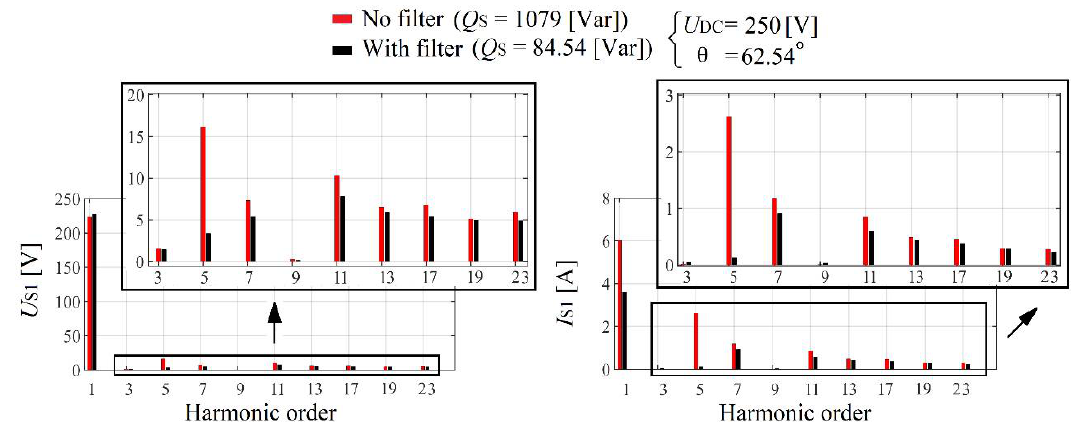
Figure 48. ( a ) Filter electiveness, ( b ) comparison between the 5th harmonic current of grid ( I S(5) ) and the input rectifier ( I T(5) ).